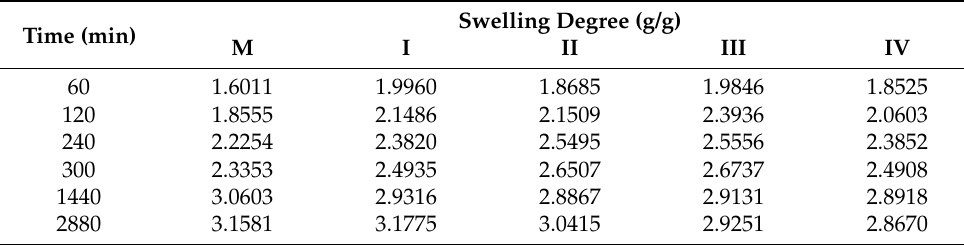
Figure 3. The plot of − ln (SWt/SWe) against ln (t) for control sample (M) and the ones containing increasing concentrations of graphene oxide (I, II, III, and IV) for swelling degree < 60%.